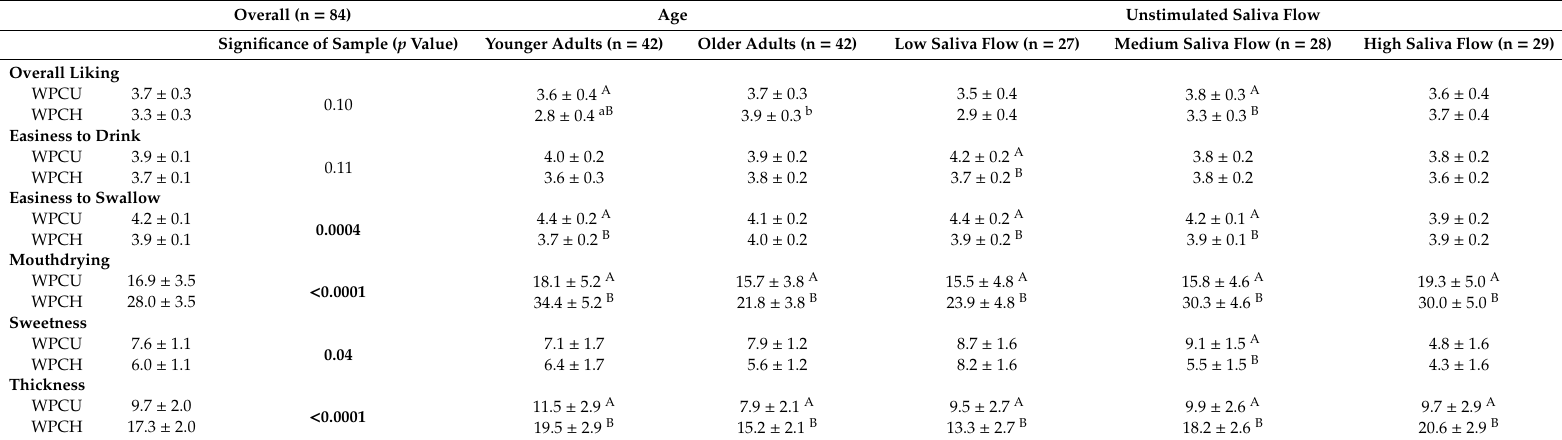
Table 4. Volunteers liking, e ff ort to consume and attribute perception mean ratings of whey protein beverages (WPB); overall and by age and unstimulated saliva flow rate.